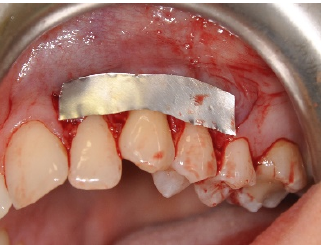
Figure 6. Preparation of adequate template for connective tissue graft (CTG).